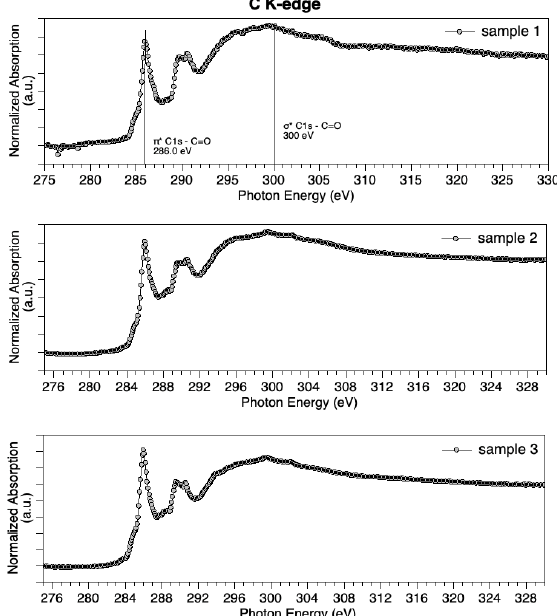
Figure 3. O K-edge spectra measured for Sample 1 ( top ), Sample 2 ( middle ) and Sample 3 ( bot- tom